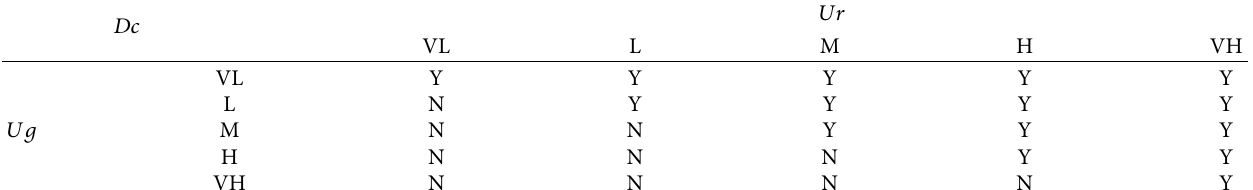
Table 5: Fuzzy rules for the decision